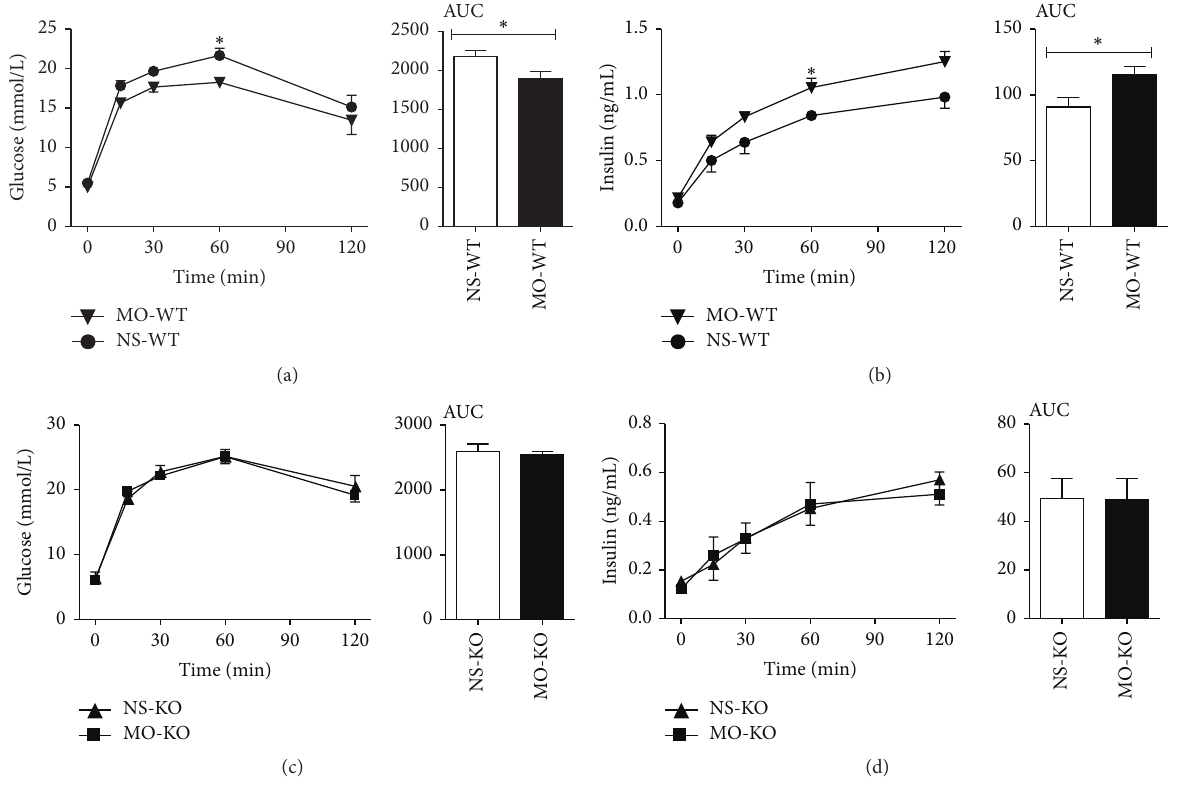
Figure 3: Glucose tolerance test in mice that received moxifloxacin or saline. (a and b) Blood glucose and serum insulin concentrations in wild-type mice that underwent a glucose tolerance test after treatment with 200 mg/kg of moxifloxacin or physiological saline. (c and d) Blood glucose and serum insulin concentrations in HERG knockout mice that underwent a glucose tolerance test after treatment with 200 mg/kg of moxifloxacin or physiological saline. ∗ 𝑃 < 0.05 , ∗∗ 𝑃 < 0.01 , 𝑛 = 5